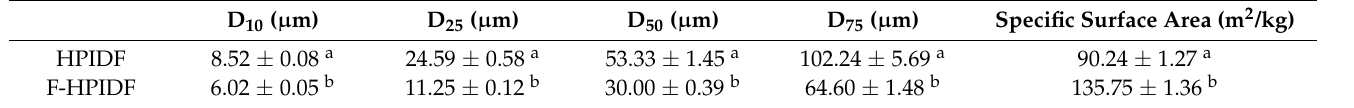
Table 1. Particle size and specific surface area of HPIDF/F-HPIDF.